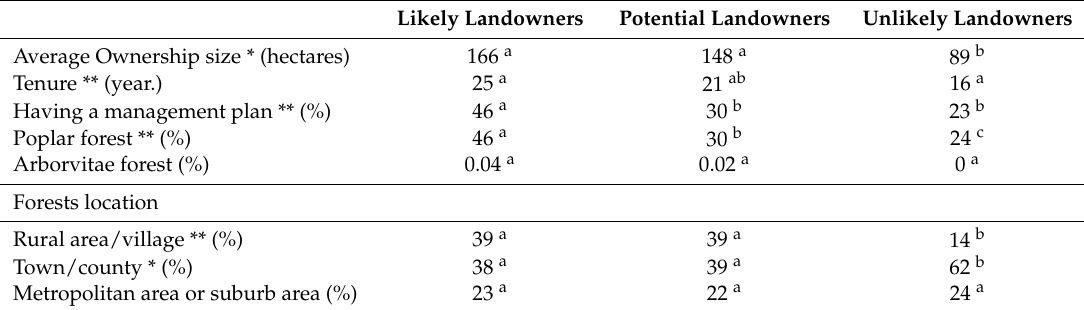
Table 3. Forest ownership characteristics by landowners